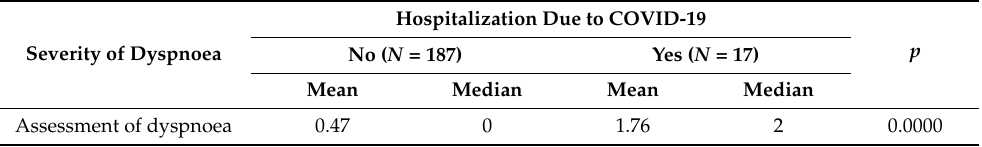
Severity of Dyspnoea